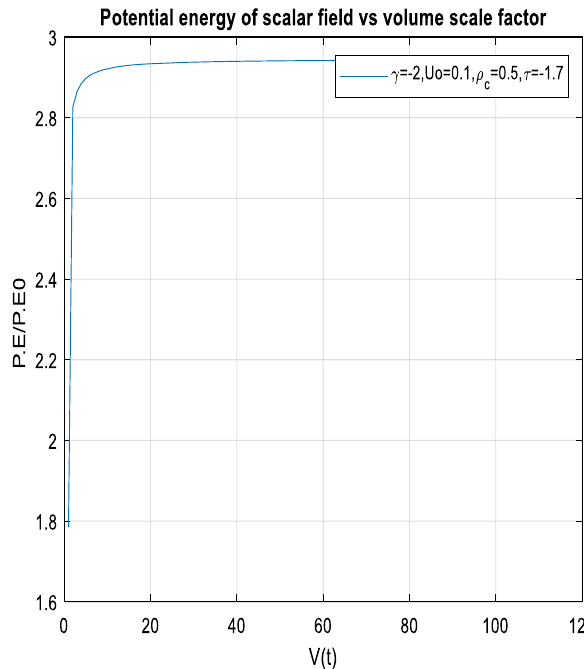
Fig. 23 Graph for potential term in fields; w = − 2 0 . 1 and τ = − 5 Therefore, for the negative viscosity we can explain slow roll scalar field mechanismproperly with all those three models.